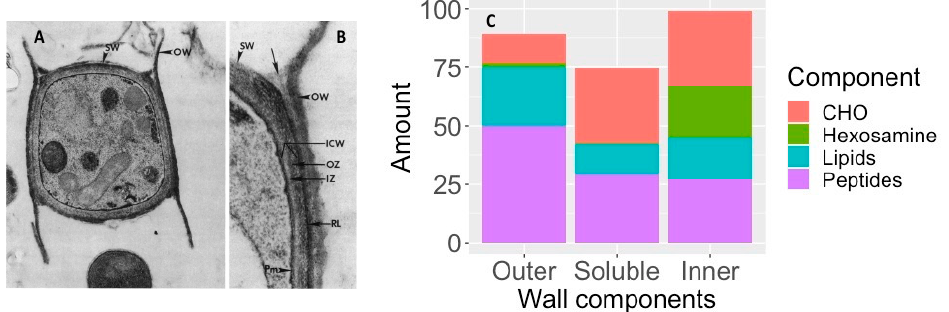
Figure 6. Components of arthroconidia cell wall. A and B: Thin sections of conidia of C. immitis showing differentiation of wall layers. OW, outer wall layer; SW, septal walls of conidium; ICW, newly formed inner conidial wall composed of the outer zone (OZ) and more homogeneous inner zone (IZ); RL, rodlet layer; Pm, plasmalemma. Arrow locates soluble conidial wall fraction (SCWF) trapped between OW and RL which is released during the cell-shearing process. ( A ), magnification × 12,000; ( B ), magnification × 27,000. The figure is from [64] and is reproduced with permission. ( C ), composition of inner and outer cell wall and SCWF. The data for this figure is from [64] .